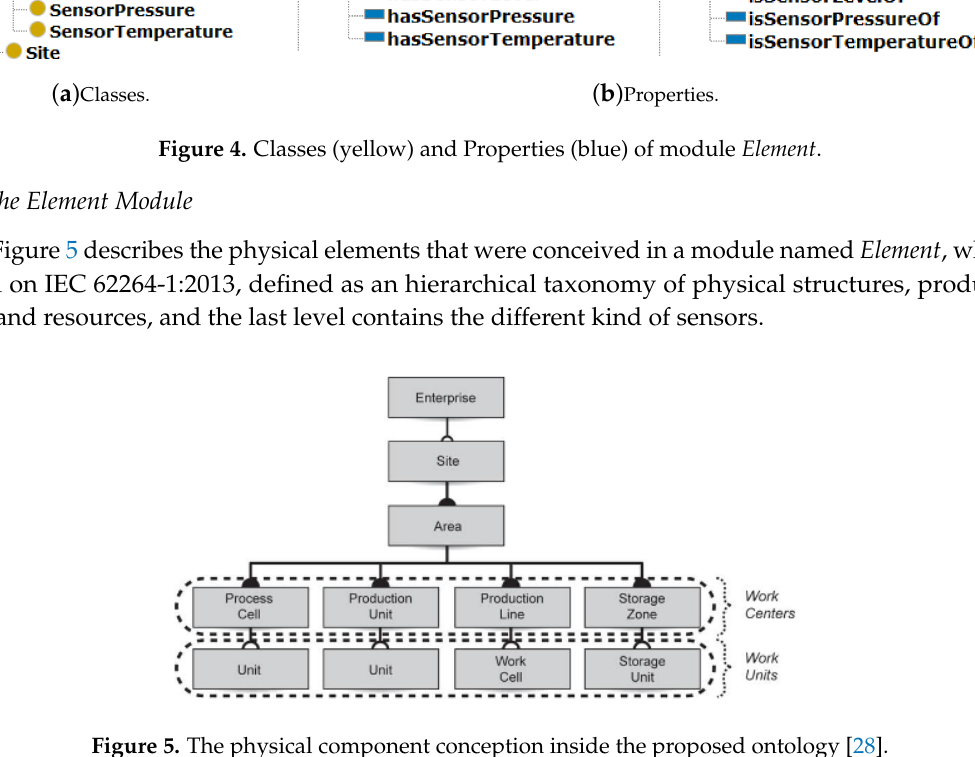
Figure 5. The physical component conception inside the proposed ontology